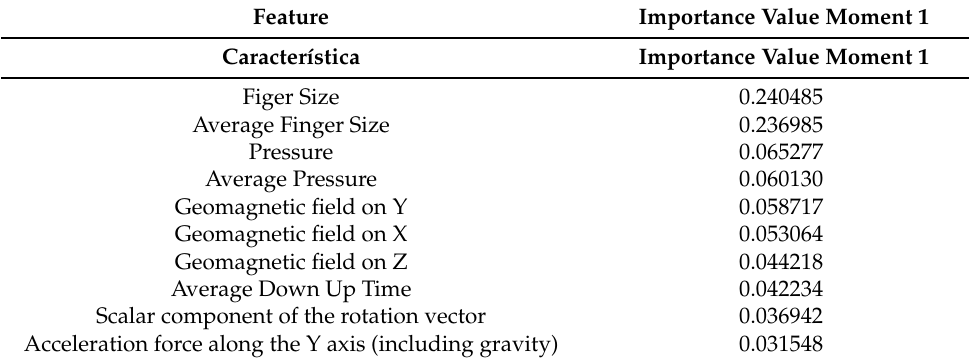
Table 7. Top 10 ranking features for Moment 1.